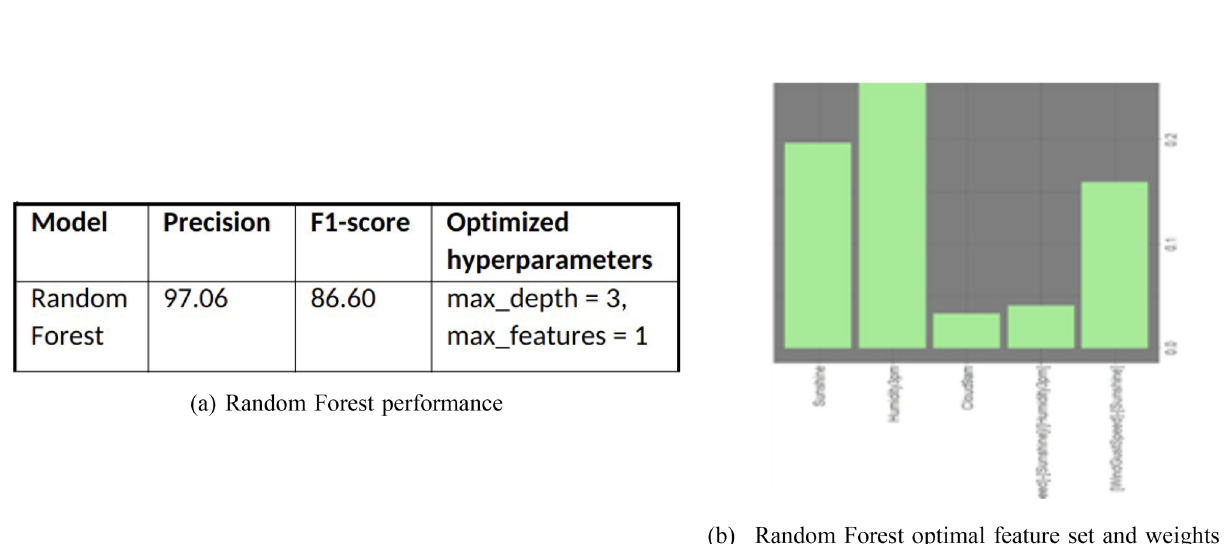
Figure 17. Random forest performance and feature